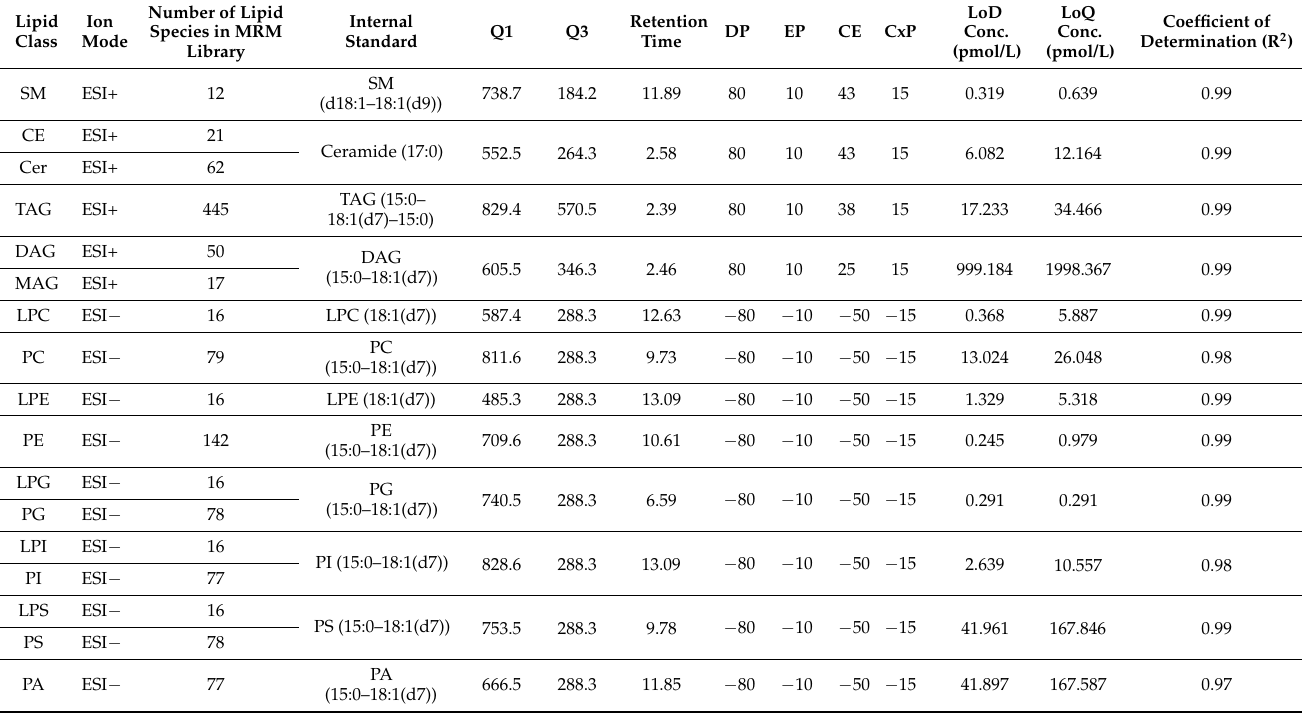
Table 1. Analytical validation of the method with lipid